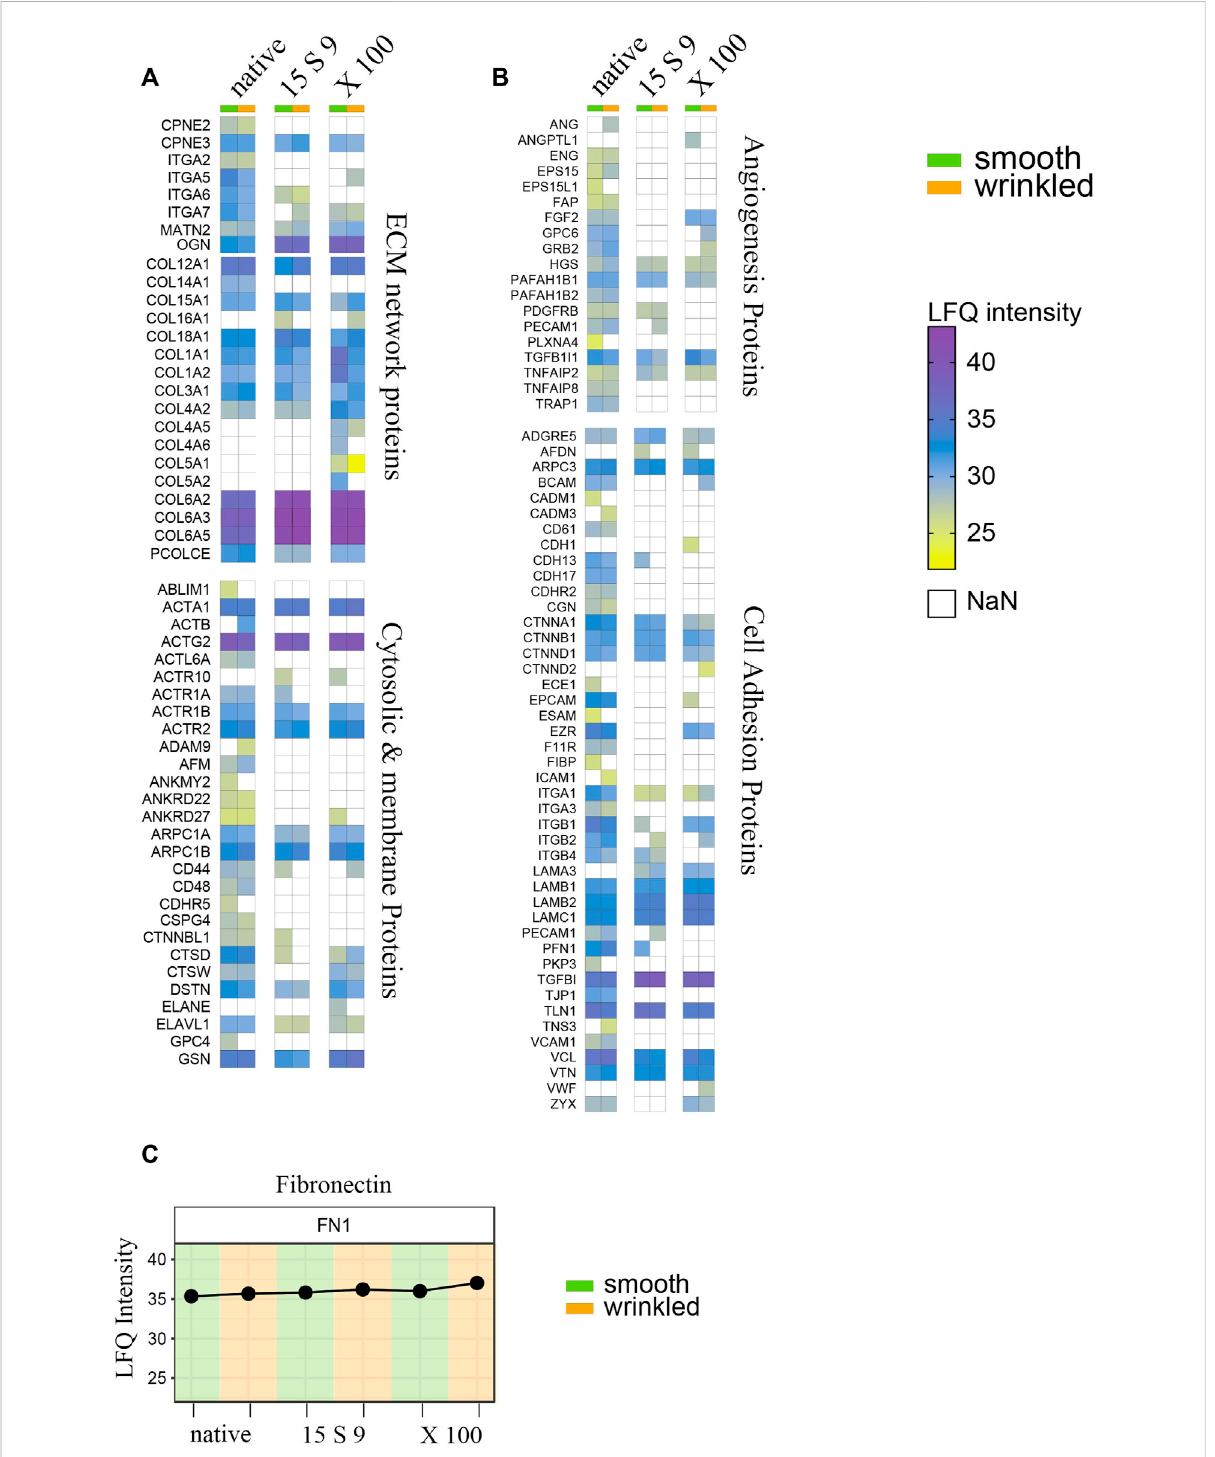
FIGURE 6 Full proteome analyses after treatments. Heatmap of label-free quantitation (LFQ) intensities of signi fi cantly changed proteins within smooth andwrinkledtissues, afterboth decellularization treatments, with theGO terms: (A) cellularproteins andcollagen; (B) angiogenesisproteins andcell adhesion proteins. (C) Pro fi le plots showing the Log 2 LFQ intensity for the fi bronectin protein detected in treated SIS